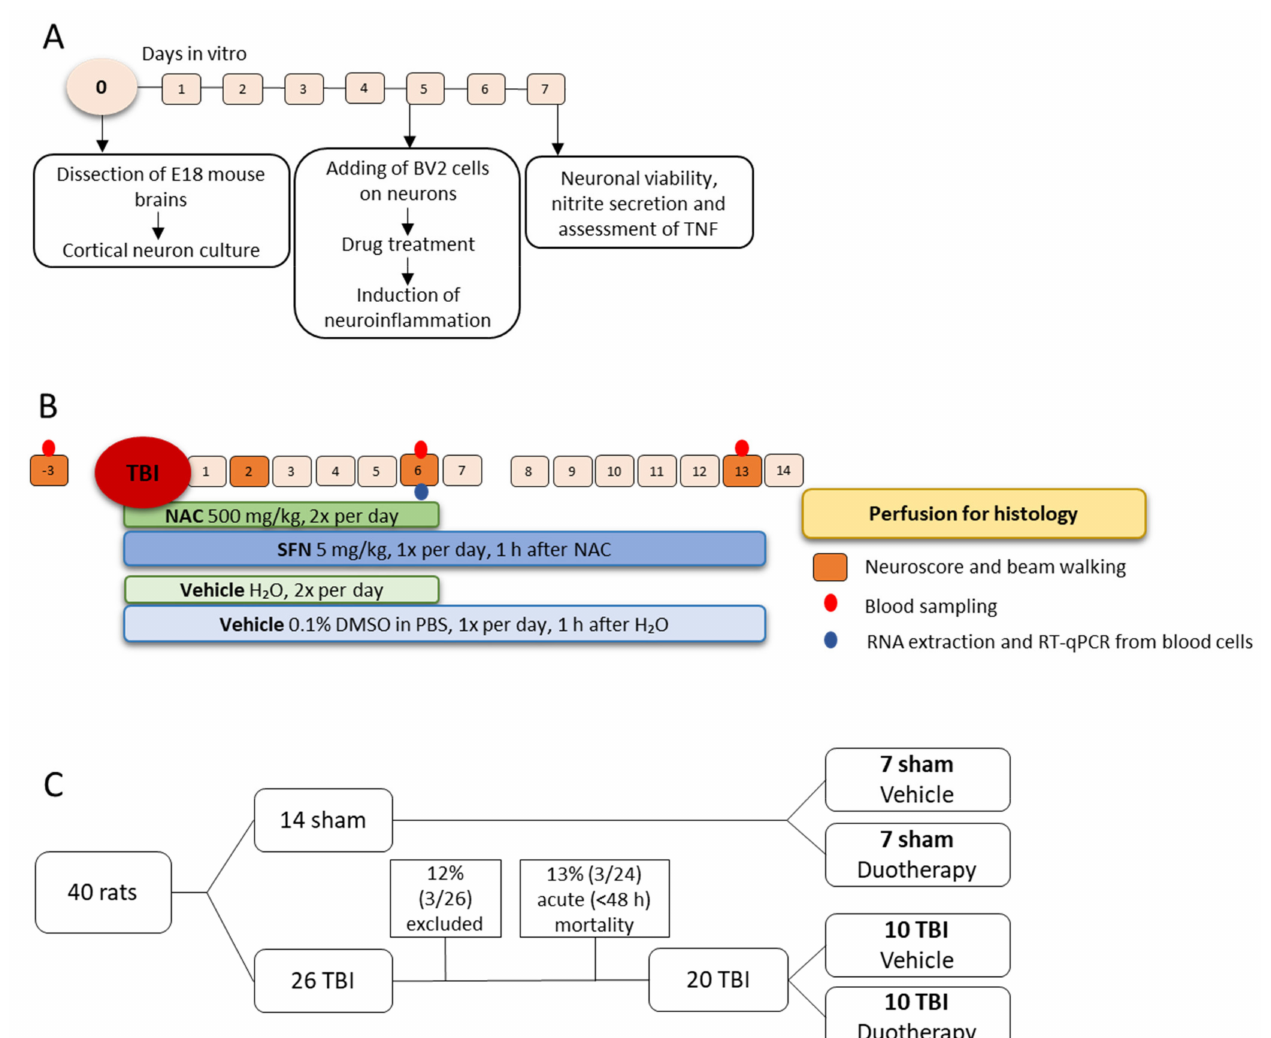
Figure 1. Study design and randomization. ( A ) In vitro study design. Primary cortical neuronal culture was prepared from E18 mouse brains. At 5 d in vitro (DIV), BV2-microglia cells were added to the culture and cells were pre-treated with N-acetylcysteine (NAC) or sulforaphane (SFN) monotherapy or SFN+NAC duotherapy under inflammatory conditions. Neuronal viability was assessed using microtubule-associated-protein 2 immunostaining described by [28]. Finally, secreted nitrite and TNF concentrations in the cell culture medium were assessed using Griess reagent and ELISA, respectively. ( B ) In vivo study design. Sham-operated experimental controls and rats with traumatic brain injury (TBI) induced with lateral fluid-percussion injury were followed-up for 2 weeks. Administration of vehicle (sterile H 2 O) or NAC (500 mg/kg in sterile H 2 O, i.p.) was started at 1 h post-impact. At 1 h later (i.e., at 2 h after TBI or sham-operation), rats were treated with vehicle (0.1% DMSO in PBS, pH 7.4, i.p.) or SFN (5 mg/kg in 0.1% DMSO in PBS, i.p.). NAC was administered twice a day (6 h apart) and SFN was administered once a day (between NAC injections). Neuroscore and beam walking tests were performed at baseline, and thereafter on days (D) 2, D6, and D13 post-TBI (injury on D0). Body weight was measured at D0, and then daily until the rats were killed. Tail vein blood was sampled for biomarker analysis at baseline, and on D6 and D13 post-TBI. On D14, rats were transcardially perfused for histology. ( C ) Randomization. A total 40 rats were included into the study. Of these, 14 animals were randomized to sham-operation and 26 to lateral fluid-percussion-induced TBI, and further, to vehicle or duotherapy treatments. One rat in the TBI group was excluded due to broken dura after the craniectomy, another rat was excluded due to a disconnected injury cap, and another due to broken dura after the impact. Acute post-impact mortality was 13%. Thus, there were 7 rats in the Sham-VEH, 7 in Sham-DUO, 10 in TBI-VEH, and 10 in TBI-DUO groups. Abbreviations: D, day; DIV, days in vitro; DMSO, dimethyl sulfoxide; DUO, duotherapy treated with N-acetylcysteine and sulforaphane; ELISA, enzyme-linked immunosorbent assay; h, hour; i.p.; intraperitoneal; NAC, N-acetylcysteine; PBS, phosphate buffered saline; RNA, ribonucleic acid; RT-qPCR, reverse transcription quantitative polymerase chain reaction; SFN, sulforaphane; TBI, traumatic brain injury; TNF, tumor necrosis factor; VEH, vehicle; wk,